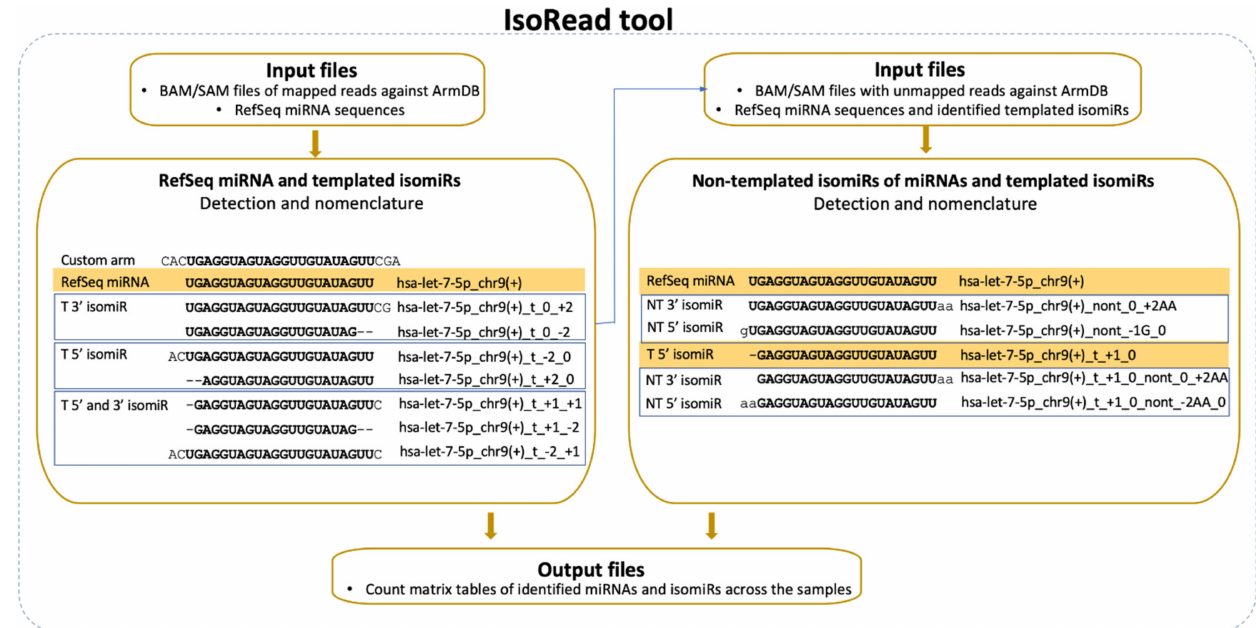
Figure 3. IsoRead tool overview. The tool performs scanning of the input SAM files from the read mapping. It discovers and classifies miRs and their isoforms in two main types—templated isomiRs (_t) and non-templated isomiRs (_nont) across samples. The coordinates in the name extension show the sequence offset relative to the RefSeq sequence. The IsoRead tool generates output files as count matrices with all discovered miRs and